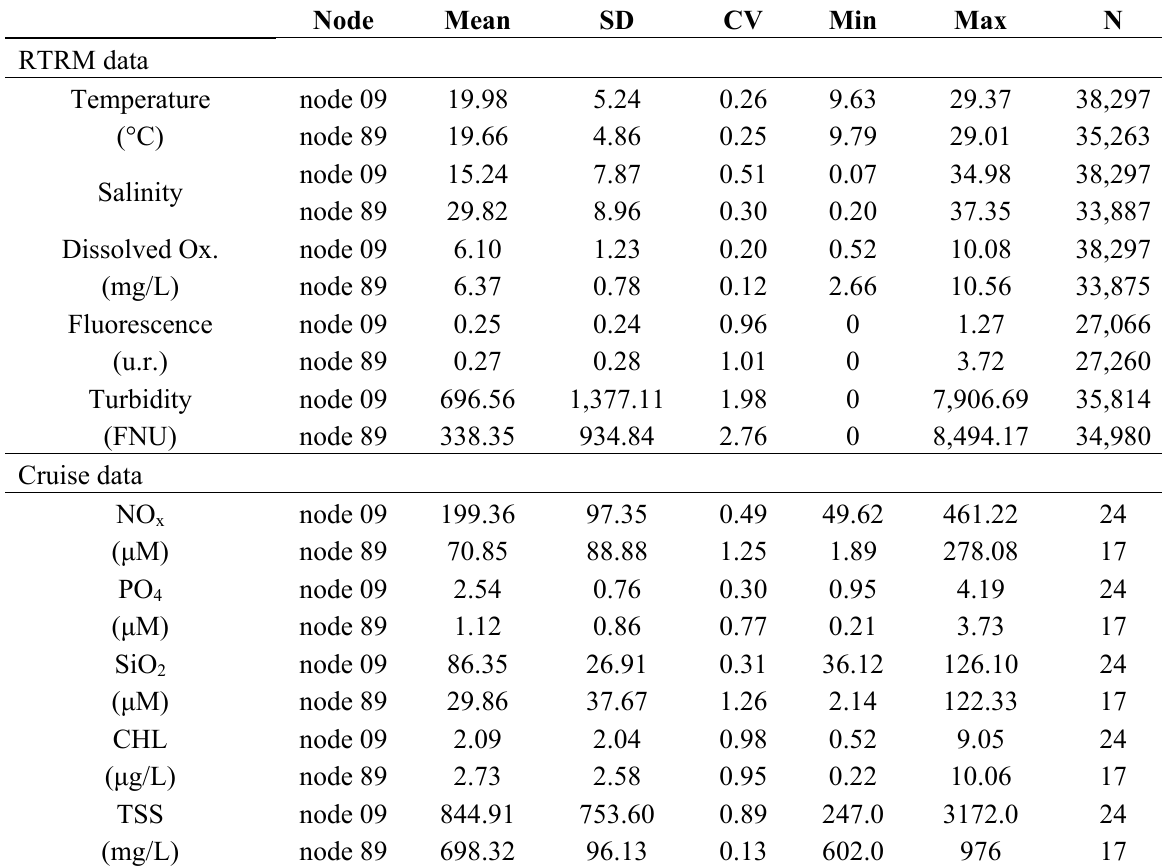
Table 2. Descriptive statistics of the data collected in nodes 09 and 89 from April 2008 to October